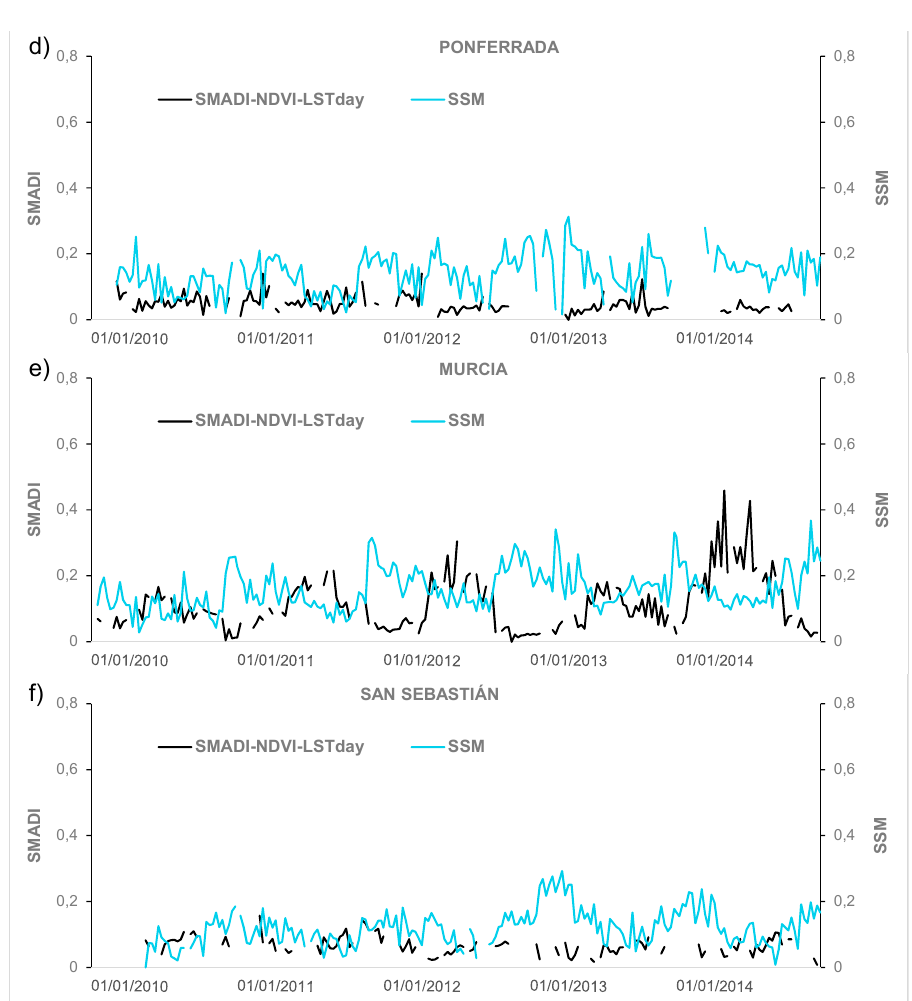
Figure 6. ( a – f ) Temporal evolution of SMADI and SSM at three dry (a,c,e) and wet (b,d,f) locations. Only the NDVI-LST day version was shown.